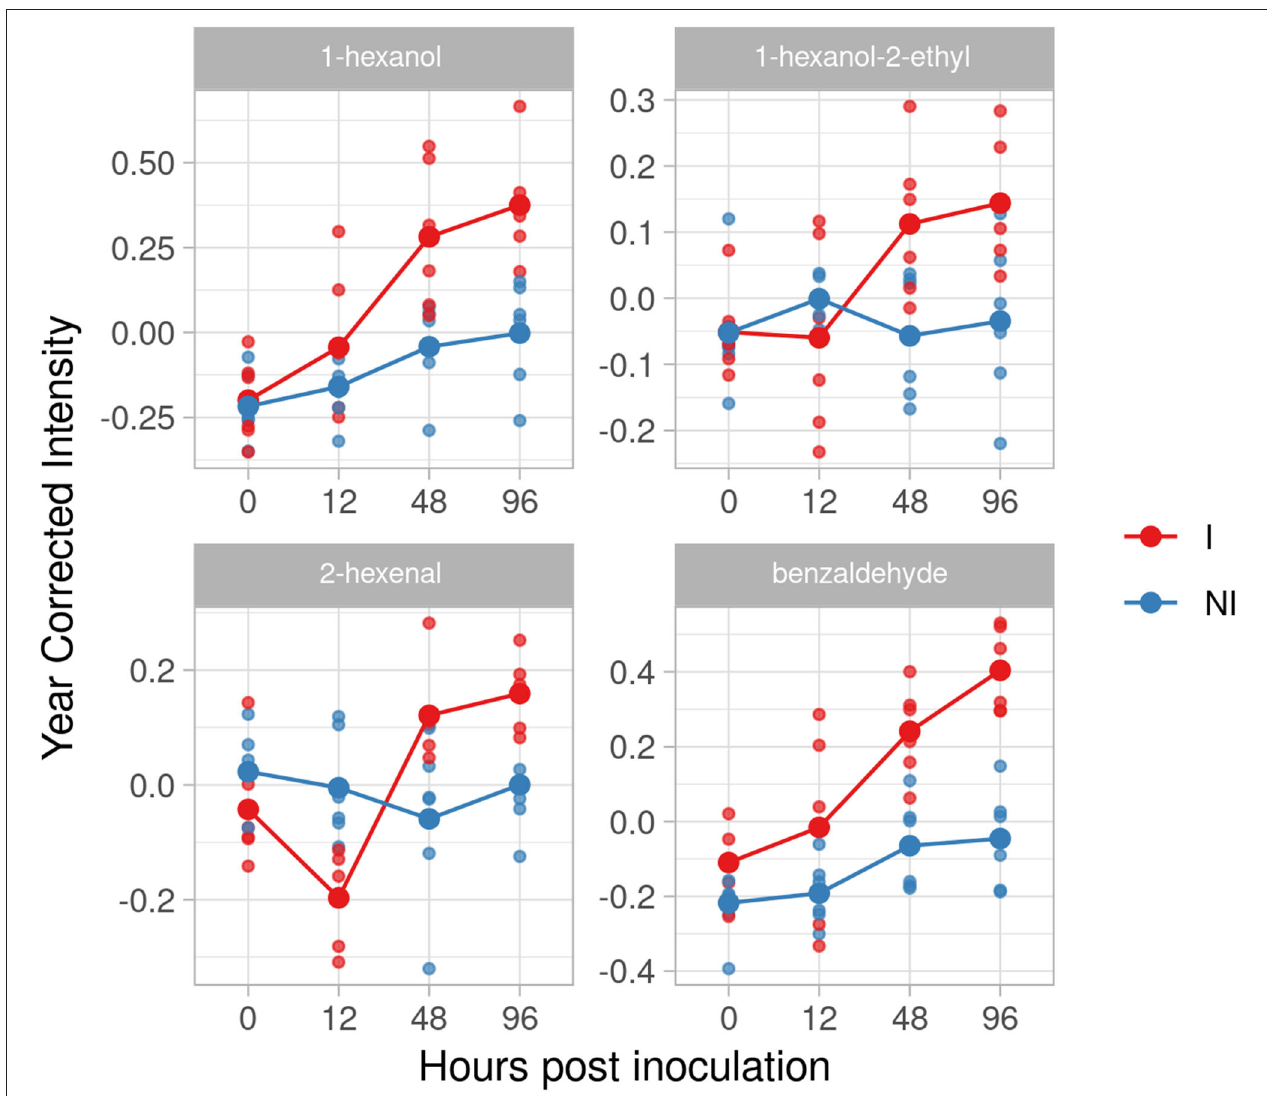
FIGURE 7 | Graphs for specific putative biomarkers of resistance to Plasmopara viticola in inoculated (Red) and not inoculated (Blue) Solaris genotype. Values of the 2 years are reported subtracting the year’s